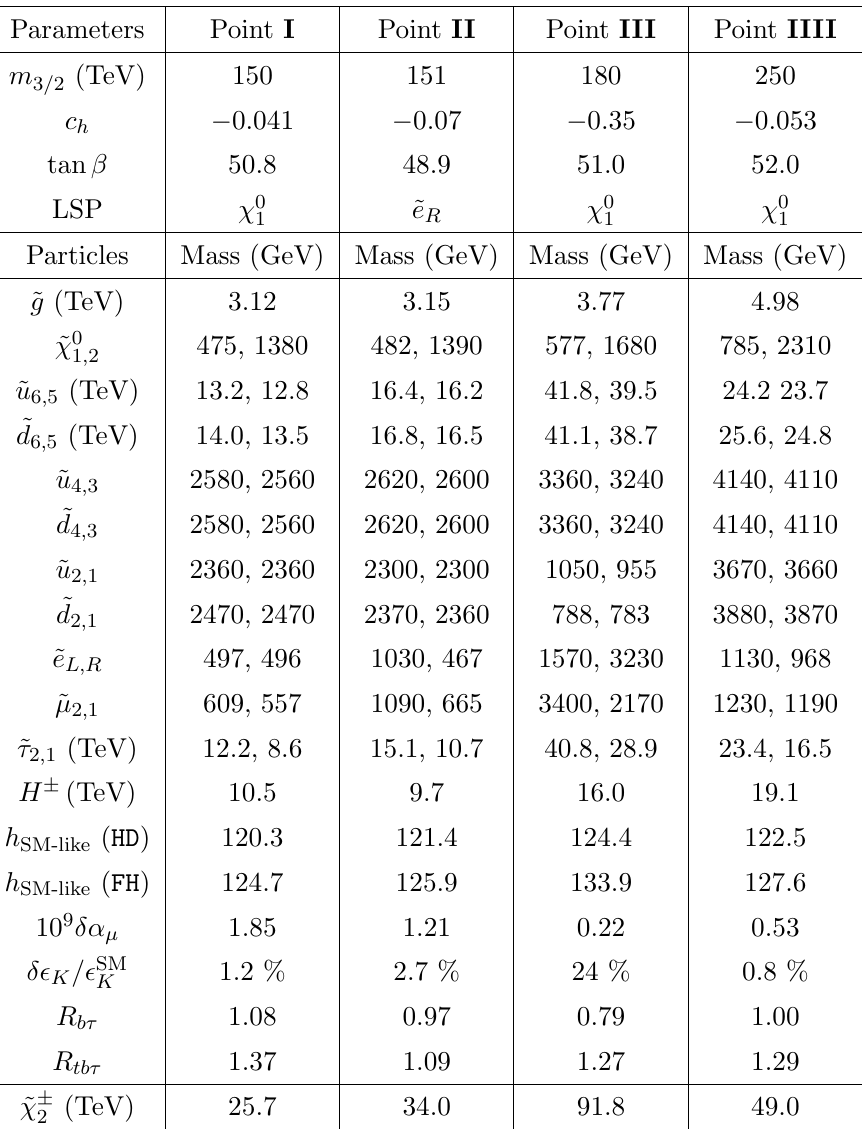
Table 1 . Mass Spectra for some model